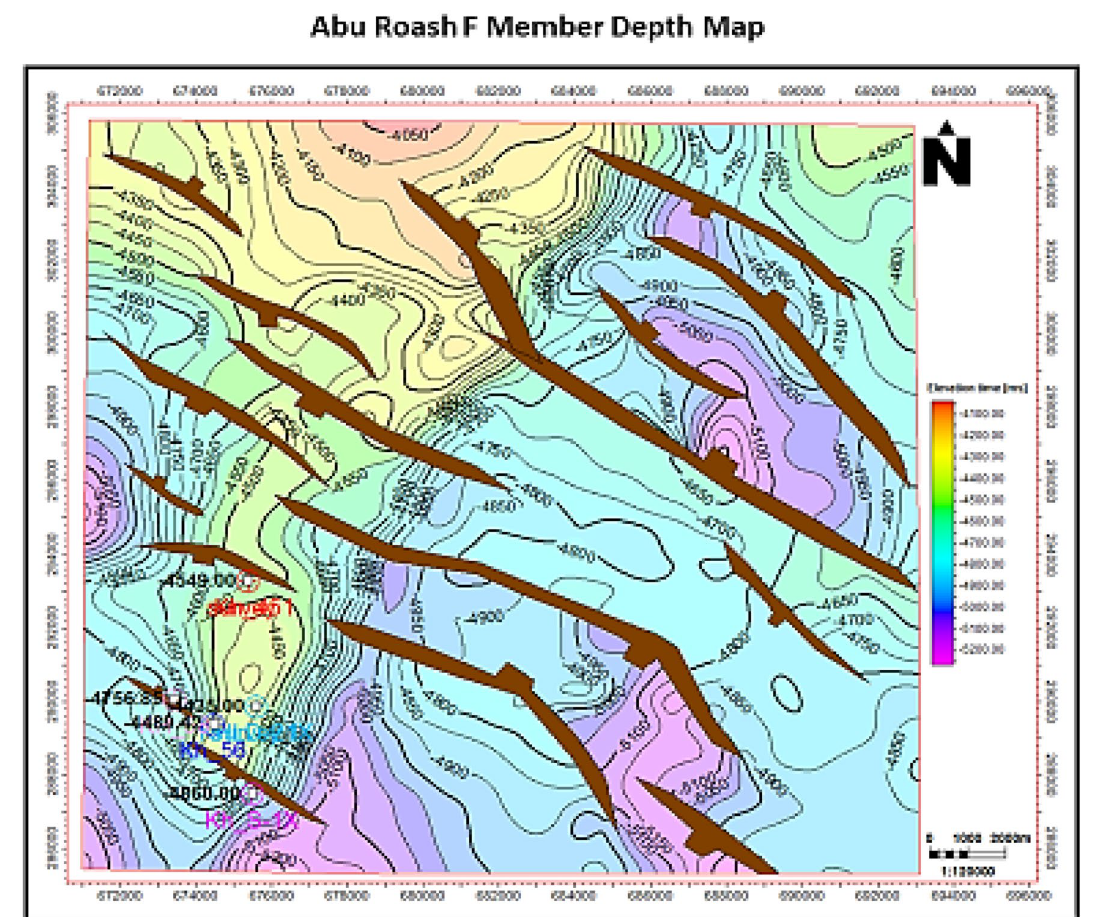
Fig. 13 The depth structural contour map on the top of Abu Roash F member (C.I = 100